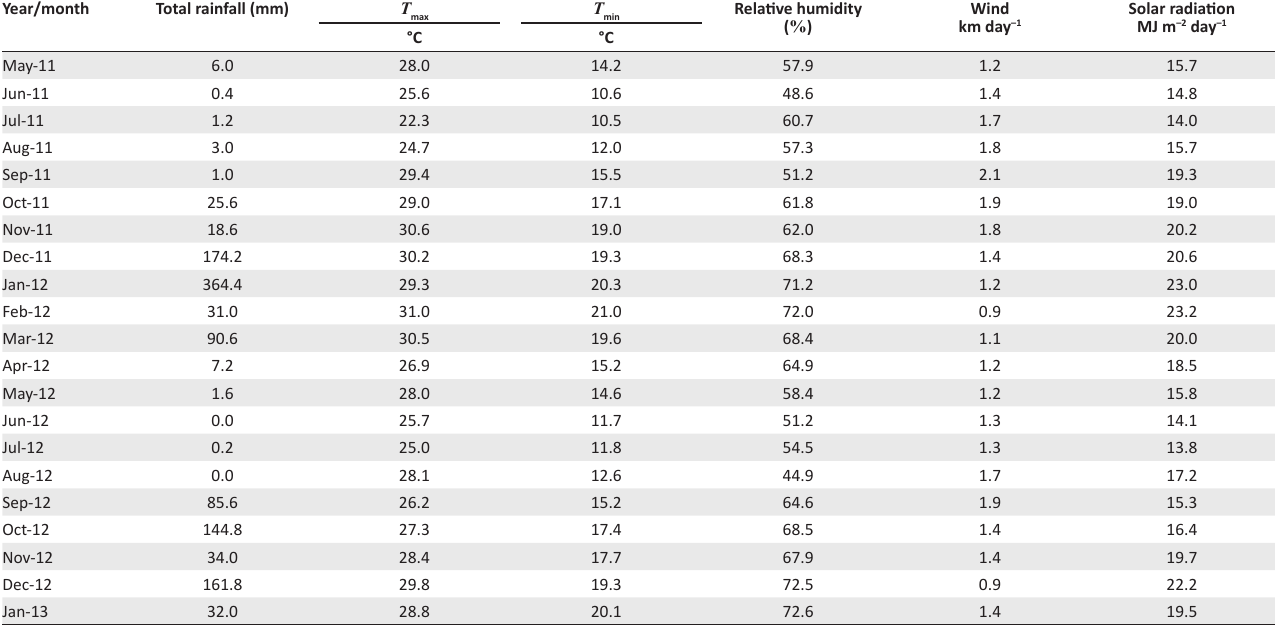
TABLE 1: Summary of climatic parameters used in simulations; total rainfall and monthly averages of temperature, humidity, wind and radiation. Year/month